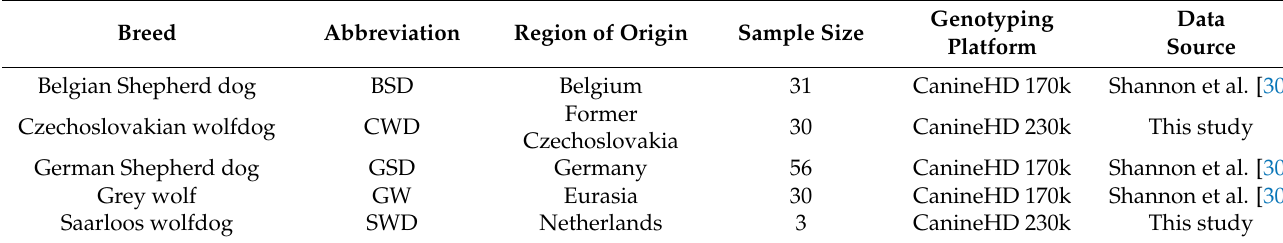
Table 1. Source of genome-wide data and sample size of analysed